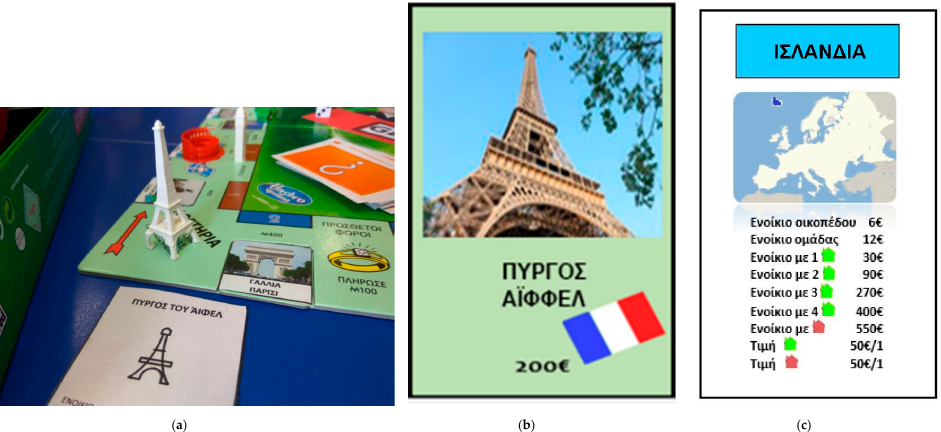
Figure 1. The Geopoly game board and cards from the game [45]. ( a ) The adapted game board and 3D printed player tokens; ( b ) a monument card (utility card); ( c ) a property card.